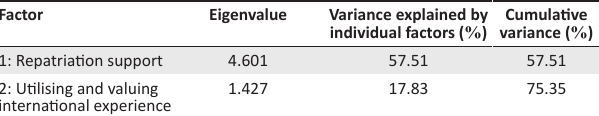
TABLE 7: Eigenvalues and variance explained.